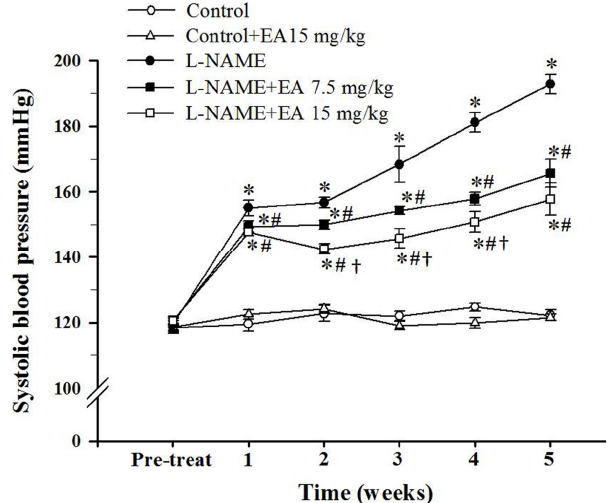
Figure 1. Effect of ellagic acid on systolic blood pressure during N ω -Nitro- L -arginine methyl ester hydrochloride (L-NAME) administration for five weeks. Values are expressed as mean ± SEM, n = 8. * p < 0.05 when compared to control group, # p < 0.05 when compared to